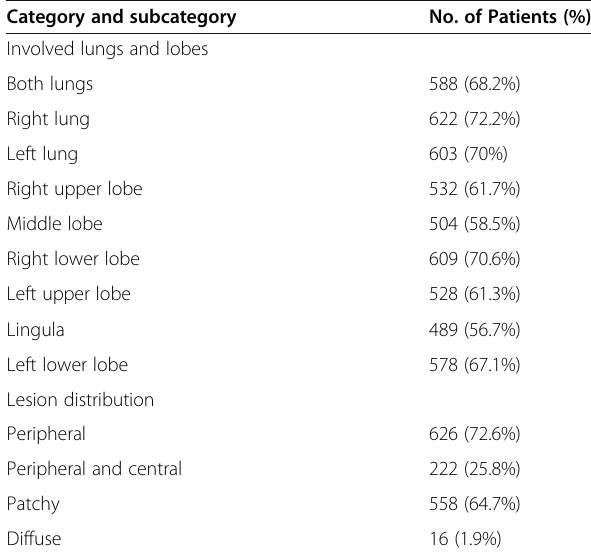
Table 4 Distribution of Lesions in COVID-19 pneumonia patients